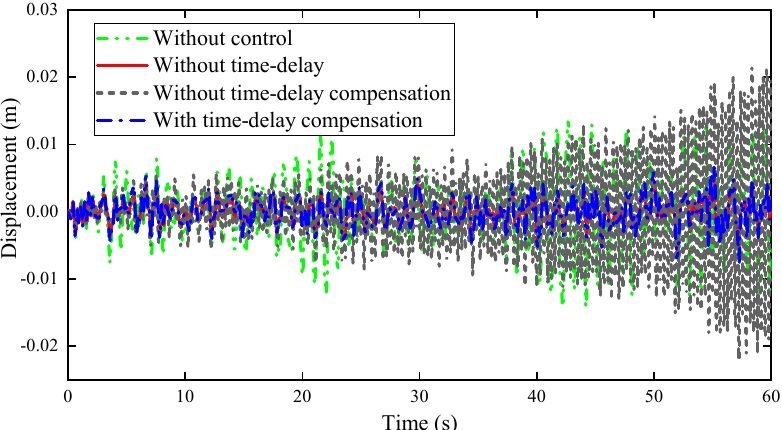
Figure 8. The time history of displacement at mid-span under random excitation (0.11 s time-delay).